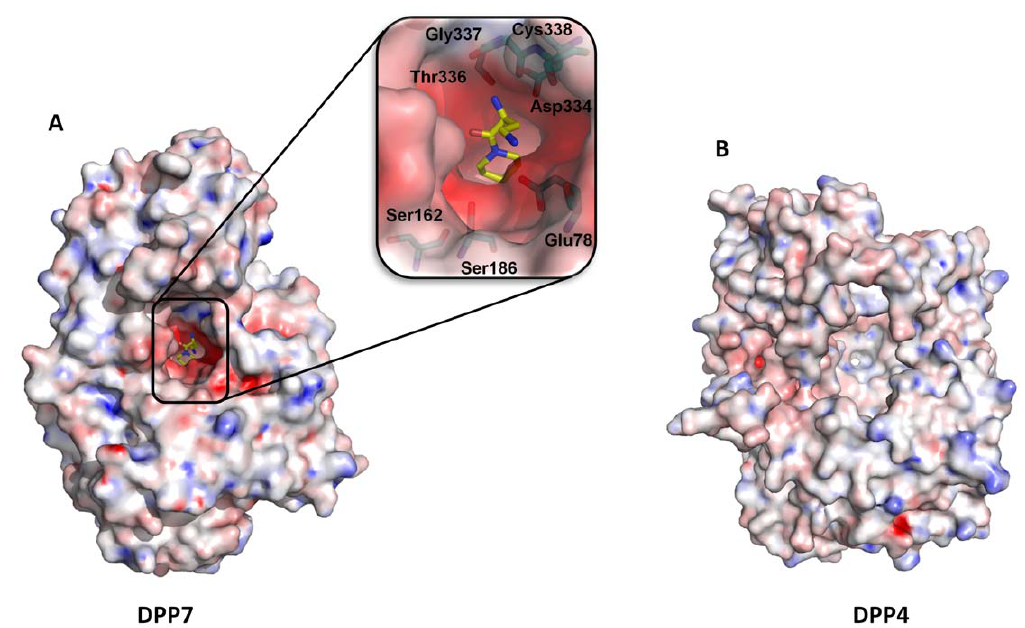
Figure 7. Poisson-Boltzmann electrostatic potential. ( A ) Surface representation of DPP7 showing the negatively charged substrate binding pocket. Inset: Zoom in the binding pocket depicting the amino acid residues that contributes to the negative charge. ( B ) Surface representation of the electrostatic potential of DPP4 evidencing the more neutral to positive charge in the binding pocket. The calculations were done with the chain A of DPP7 (PDB code 3JYH) and DPP4 (PDB code: 3EIO) using the software APBS [43]. The figure was prepared using the program PyMOL (http://www. pymol.org/).